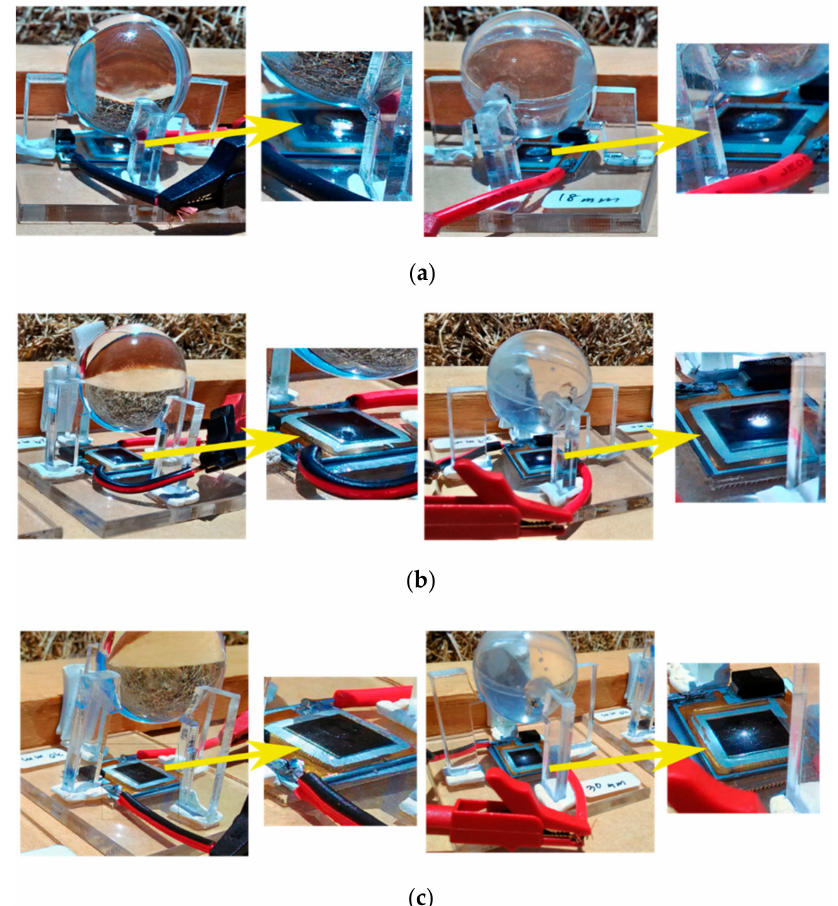
Figure 15. Photographs of concentrated sunlight by the homogenous (left) and the CSSP lenses (right) with different focal lengths f : f = ( a ) 18 mm, ( b ) 24 mm, and ( c ) 30 mm.